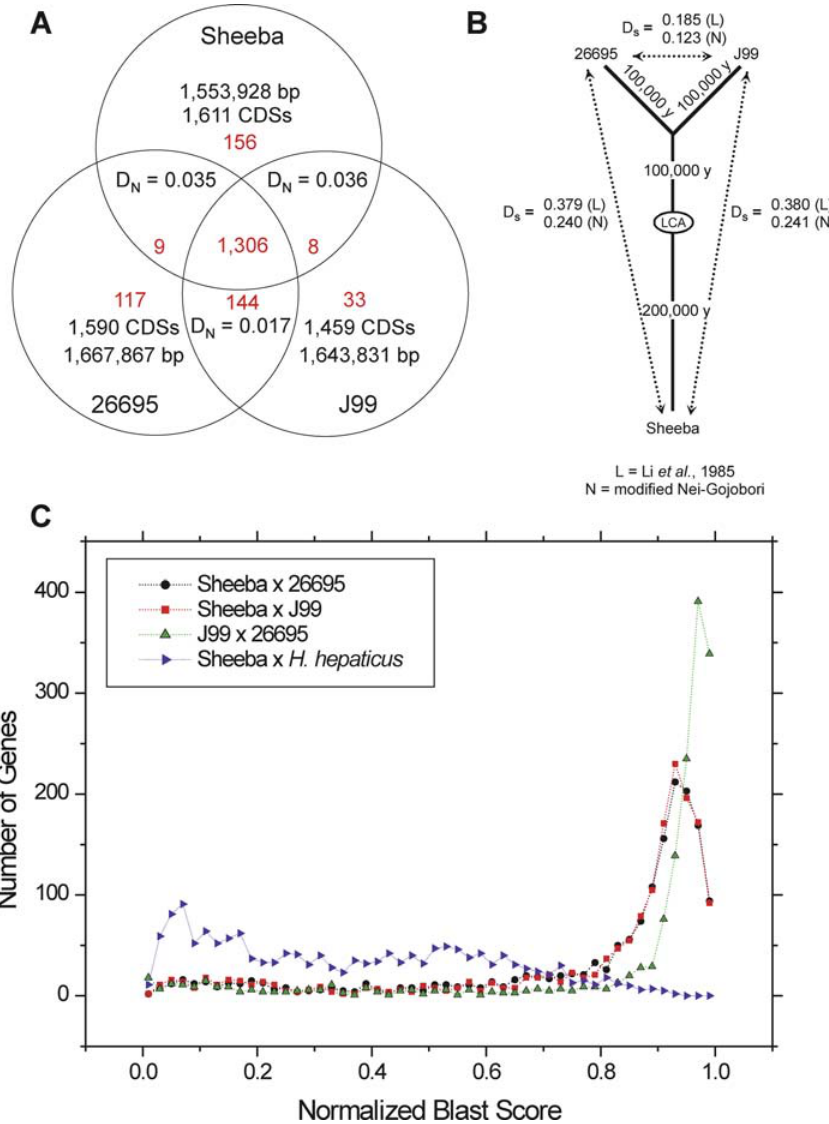
Figure 2. Similarities between the Genomes of H. acinonychis Sheeba and H. pylori 26695 and J99 (A) Venn diagram of genomic properties. Numbers in red within each arc represent numbers of genes, each of which may contain multiple CDSs if the corresponding gene is fragmented. (B) Age calculations since a common ancestor (LCA) based on synonymous pair-wise distances for 612 conserved genes according to the methods of Li et al., 1985 and the modified Nei-Gojobori method. (C) Frequencies of normalized blast scores in pair-wise comparisons between Sheeba and three other genomes. DOI: 10.1371/journal.pgen.0020120.g002